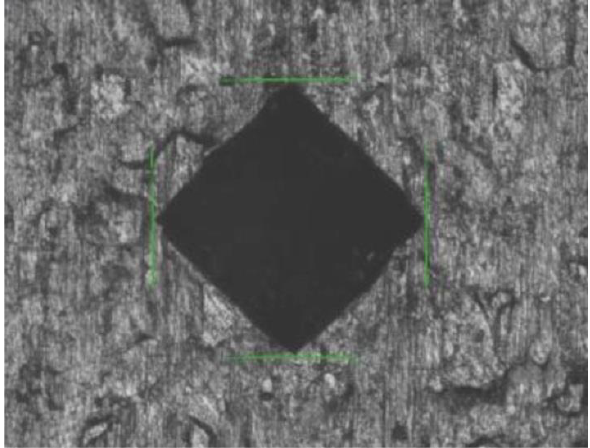
Figure 2. Test point image.